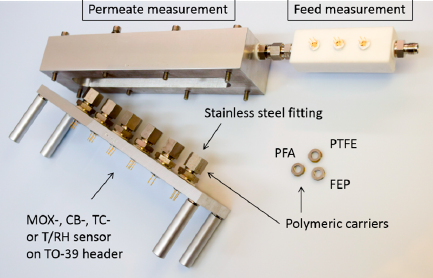
Figure 2. Experimental setup for study the separation properties of fluoropolymers. In the right PTFE chamber, six sensors on TO-39 header are integrated. Different types of sensors can be used to measure the gas concentration, temperature and humidity in the Feed. In the left chamber, the sensors are soldered into interchangeable stainless steel fittings to measure the gas concentration, humidity and temperature in the Permeate. The Polymeric carriers are screwed-in with EPDM and PTFE seals.